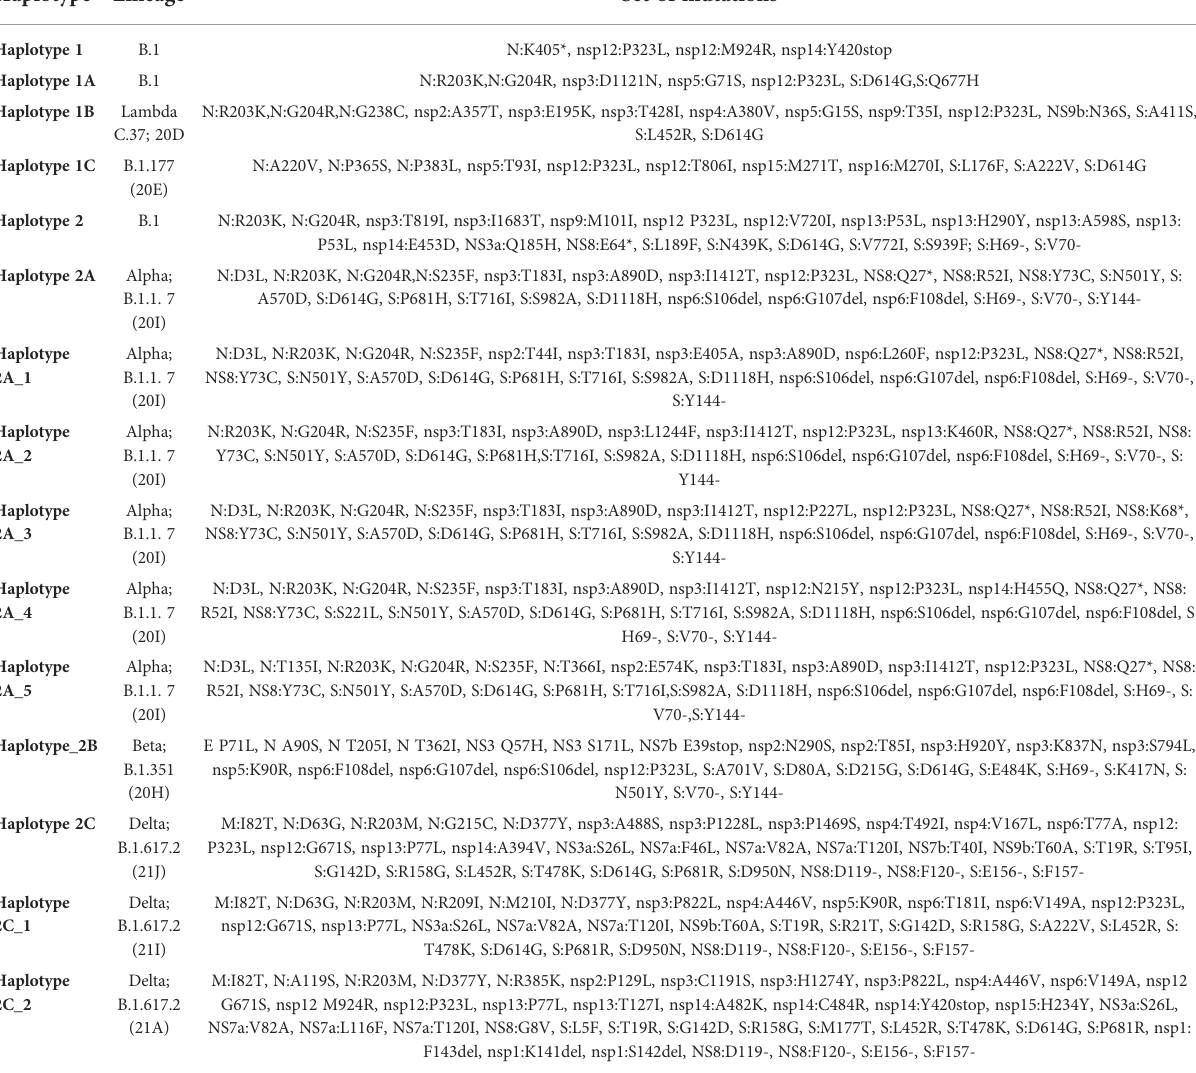
TABLE 2 Haplotypes and the corresponding mutations. Haplotype Lineage Set of mutations Haplotype 1